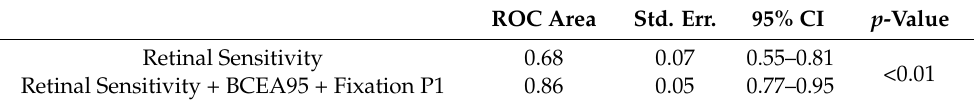
Table 4. ROC Area comparison between retinal sensitivity alone, and retinal sensitivity and fixation parameters (P1 and BCEA95). The outcome is mild cognitive impairment (MCI) (reference = normal cognition).